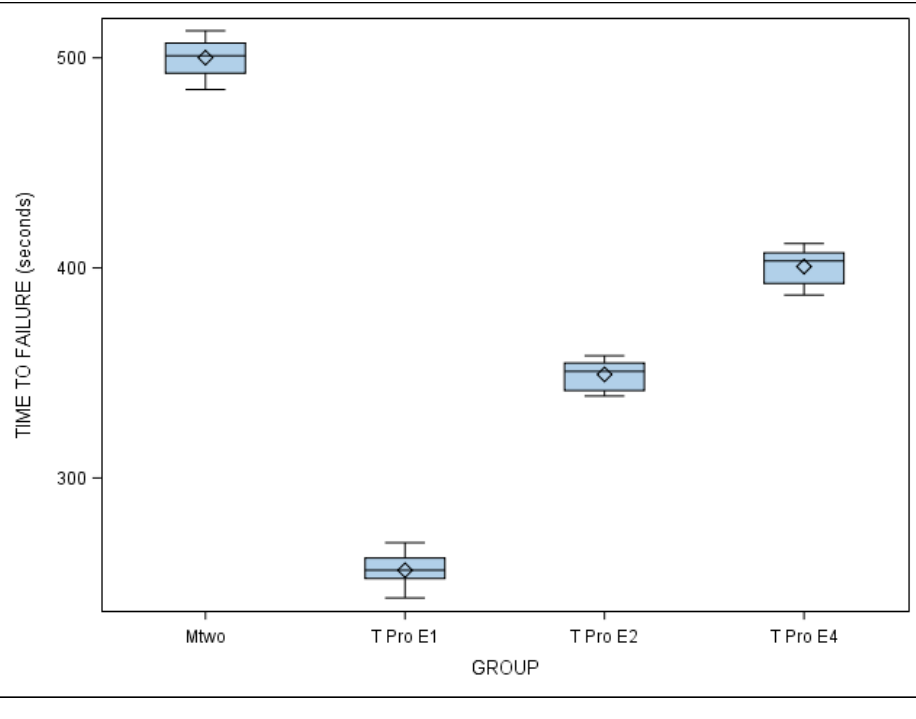
Figure 4. Box plot of the time to failure of Mtwo NiTi alloy endodontic rotary files, T Pro E1 austenite phase NiTi alloy endodontic rotary files, T Pro E2 austenite phase NiTi alloy endodontic rotary files, and T Pro E4 austenite phase NiTi alloy endodontic rotary files.